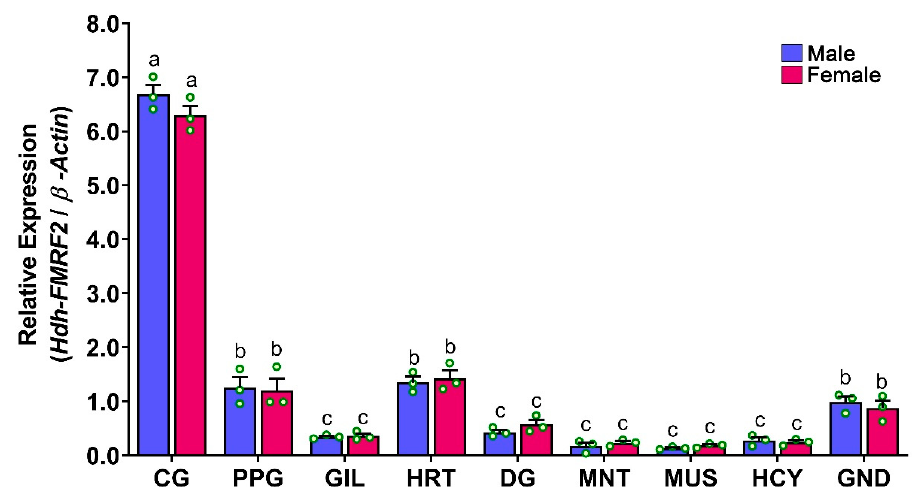
Figure 6. Confocal laser microscopic image of fluorescence in situ hybridization (FISH) of Hdh- FMRF2 mRNA in the cerebral ganglion of adult Pacific abalone. ( A ) Single confocal optical sections showing positive signal (arrow) of Hdh-FMRF2 mRNA (green) when hybridized with the anti-sense probe (1st and 2nd row) and no hybridization signal when hybridized with sense probe (3rd row) ( B ) The nuclei are counterstained with DAPI (blue). ( C ) Merged image of ( A , B ). Scale bar: 50 µm.